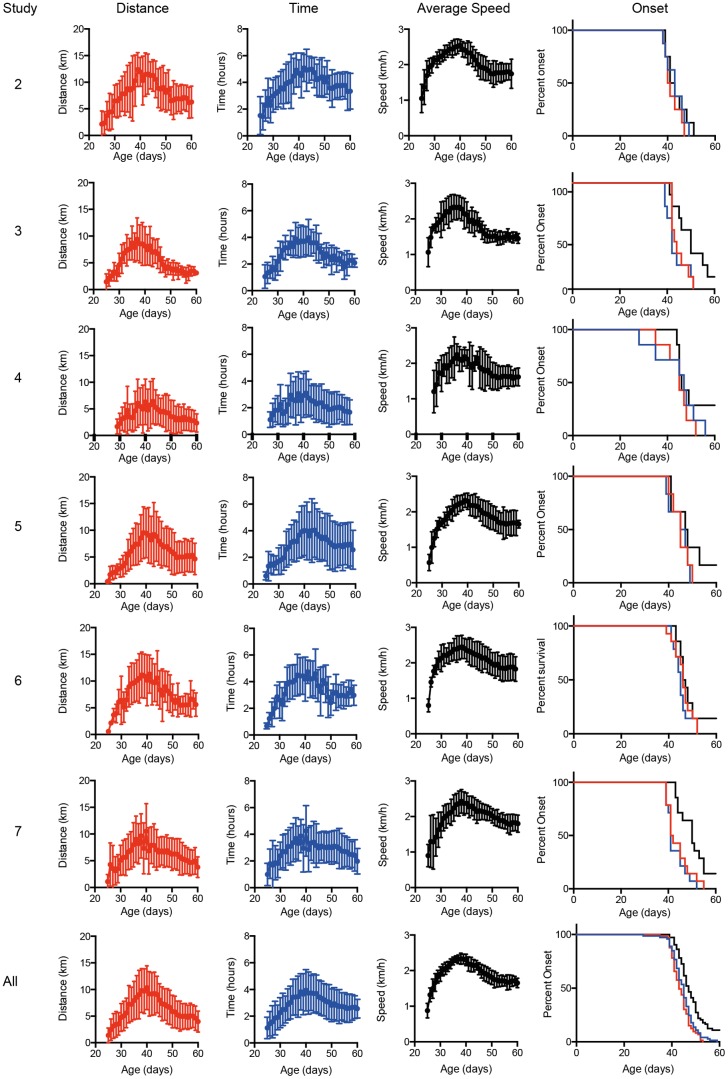
Reproducibility of running wheel average speed as an early readout of motor dysfunction.Data obtained from placebo control animals in six separate preclinical studies are shown (Studies 2–7). In addition, combined results from all seven studies are shown to illustrate the reproducibility of this methodology. Onset determined by a 20% decline in the distance run is shown red, time spent running is shown in blue and average speed is shown in black.